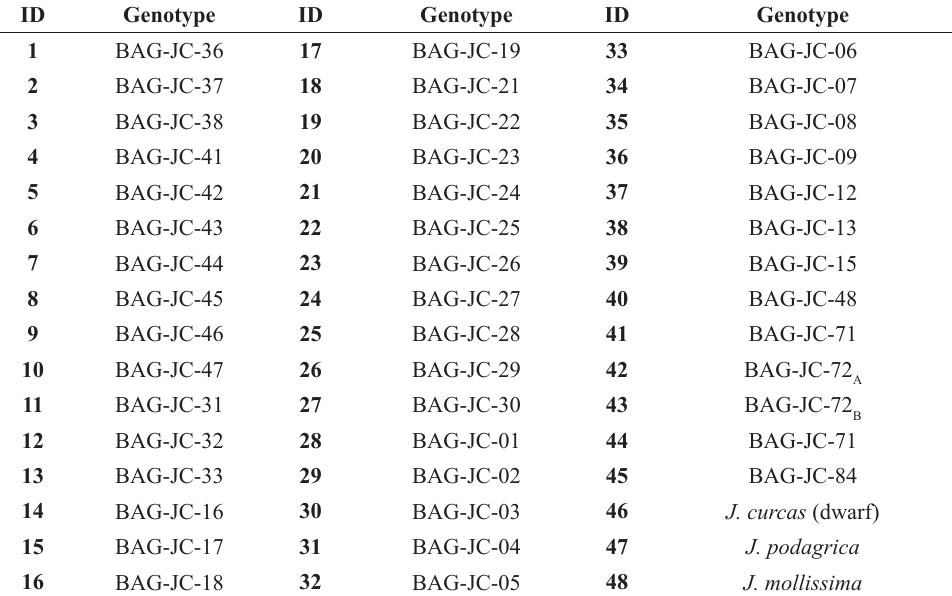
Jatropha accessions with their laboratory and field identification numbers